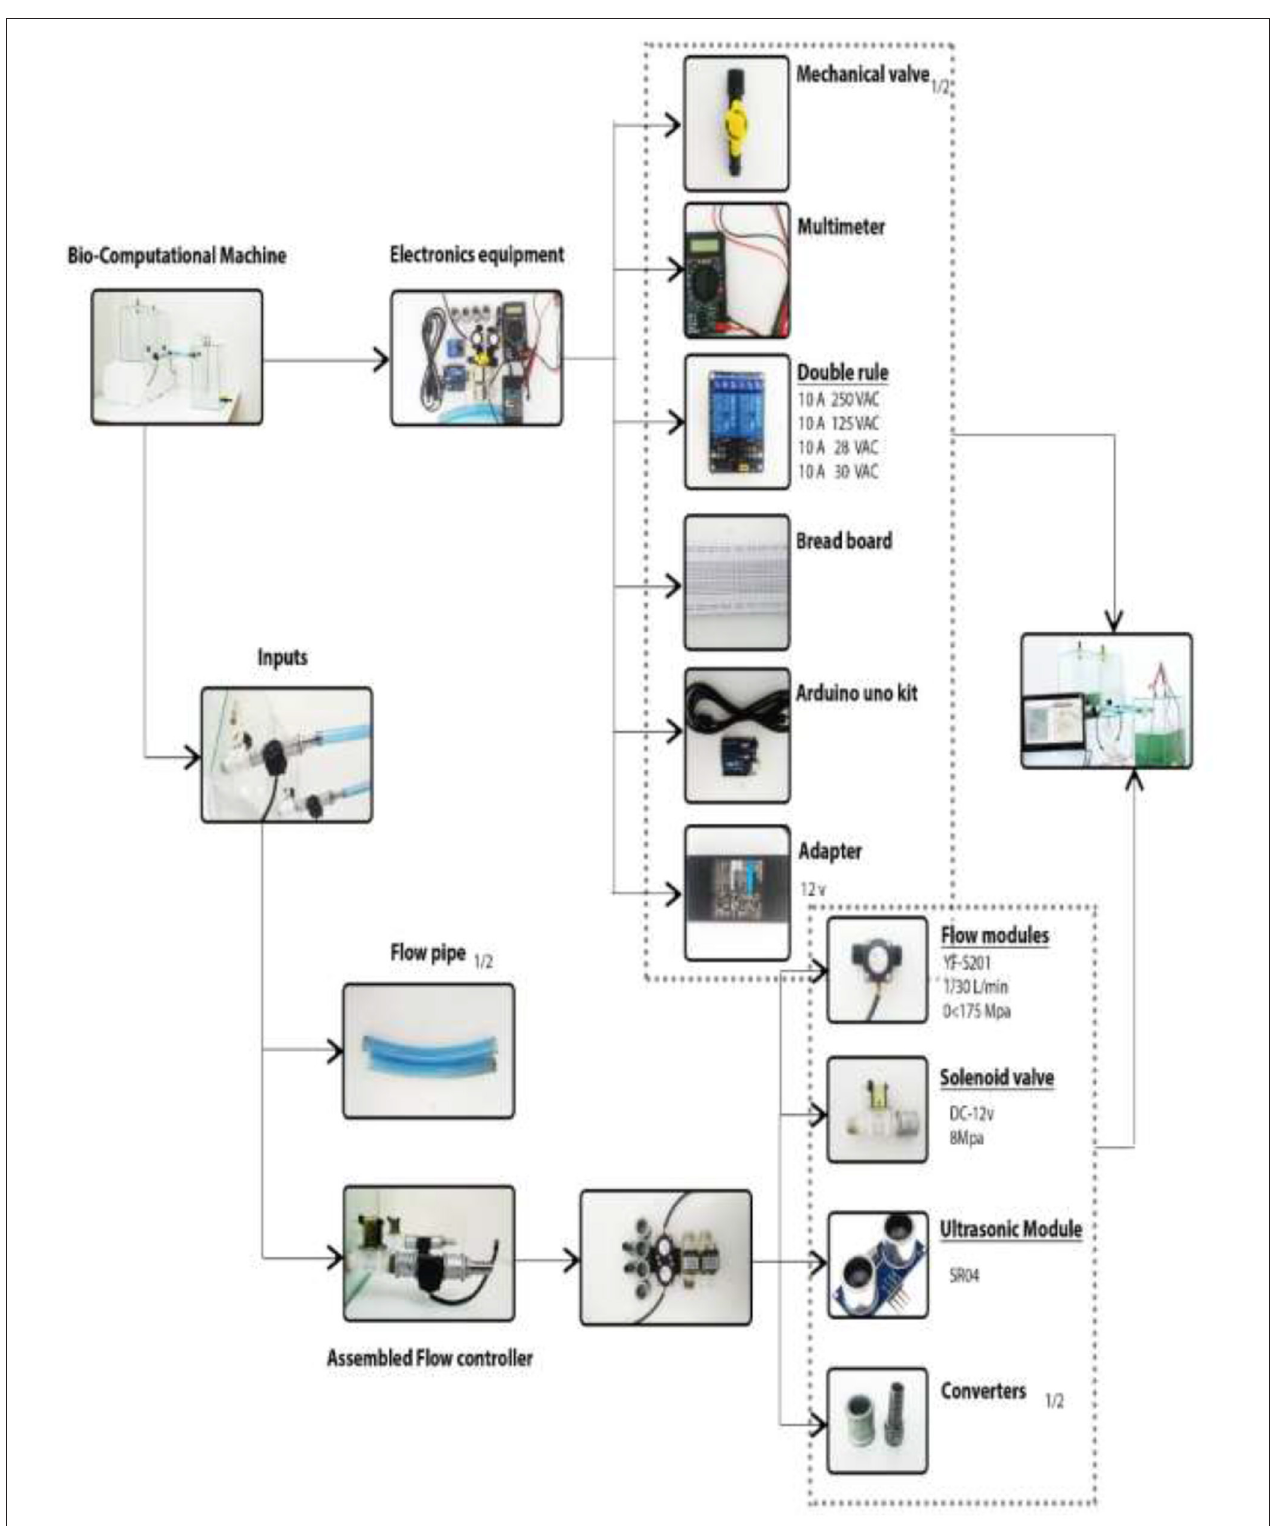
FIGURE 3 | Details of